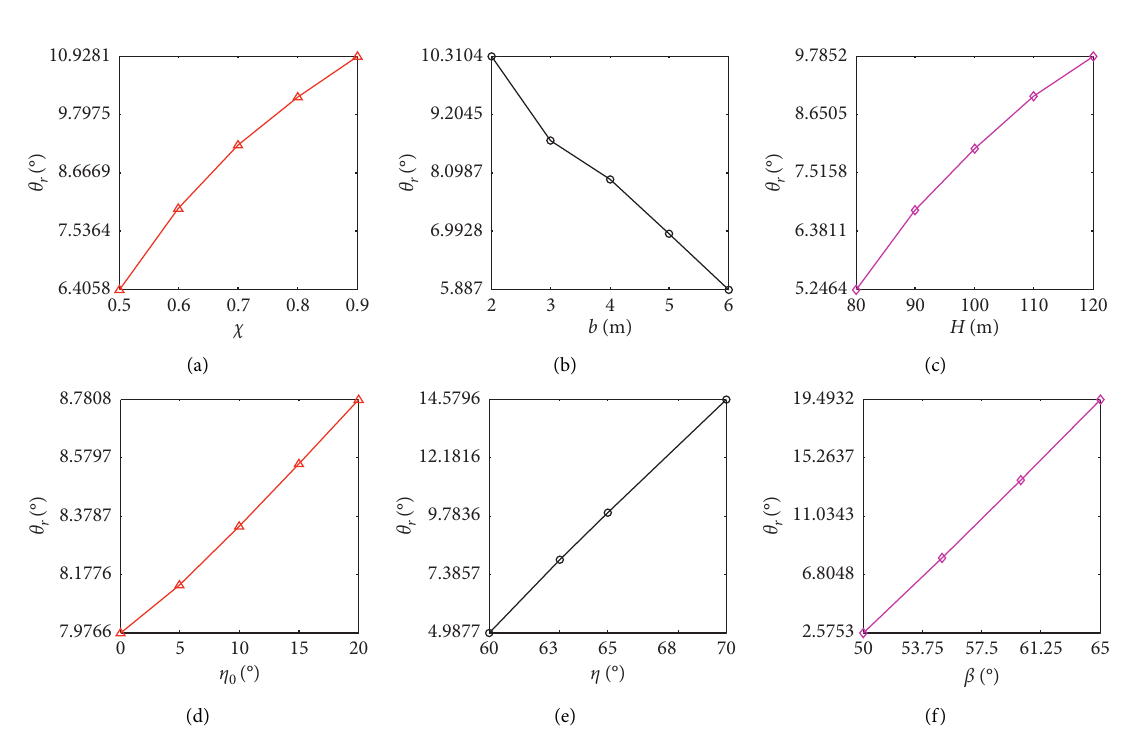
Figure 10: Sensitivity analyses of geometrical parameters of the slate slope in South